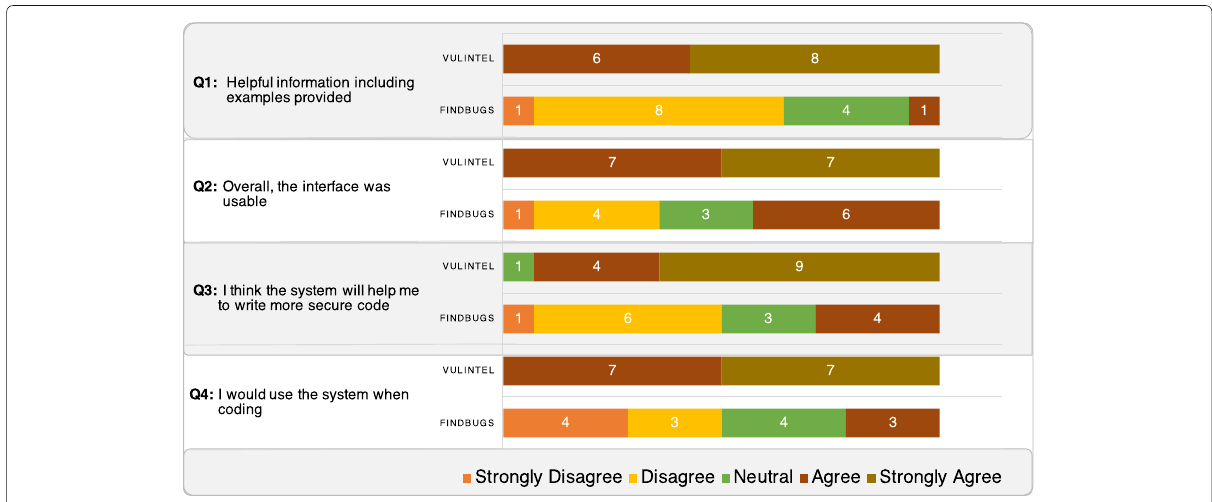
Fig. 10 Summary of participants’ responses to four main questions